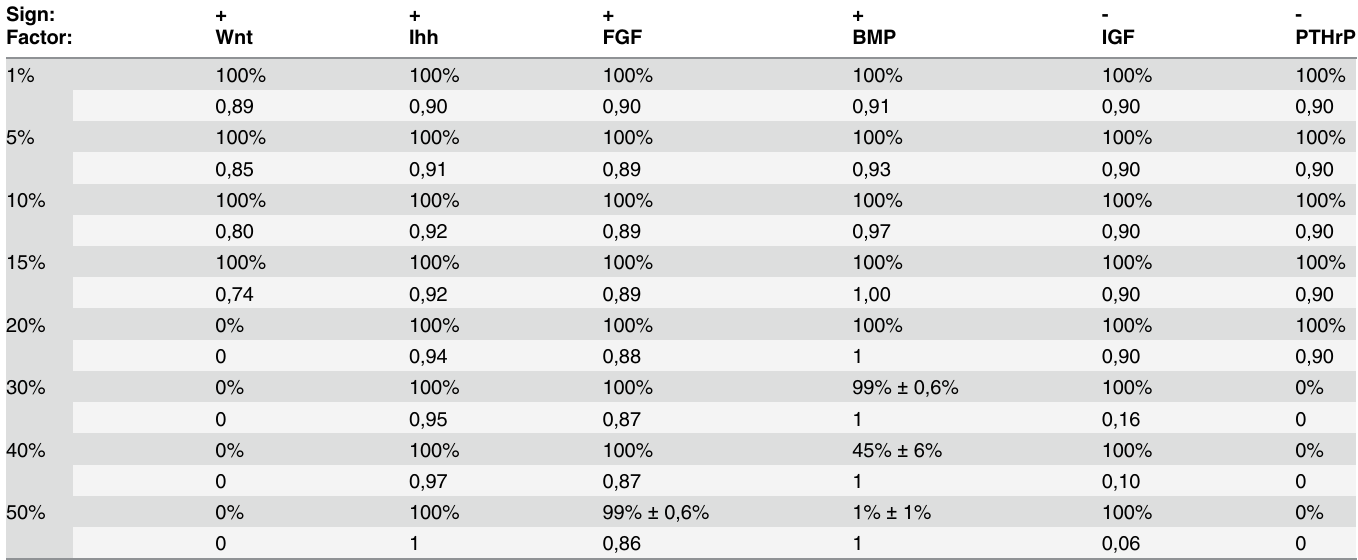
For the six growth factors present in the model, the effects of increasing perturbations are tabulated. The upper number in each cell indicates the percentage of runs that remains in the attractor (i.e. the fraction of perturbations that does not result in a switch to a different attractor). The lower number in each cell indicates the activity of Sox9 in the attractor. The wild type activity of Sox9 is 0,9. The simulations were done in triplicate. When relevant, the standard deviation is